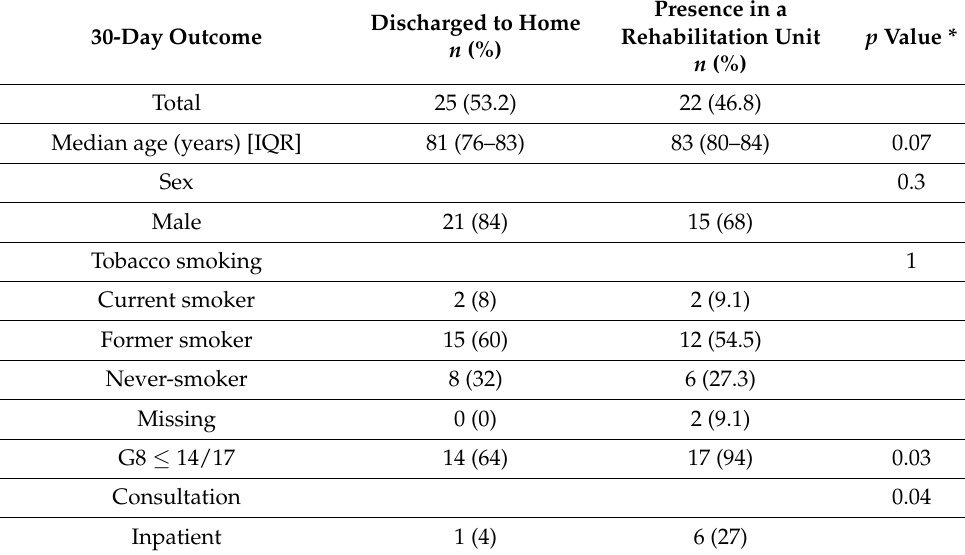
Table 3. Univariate analyses of factors associated with the 30-day outcome (discharge or